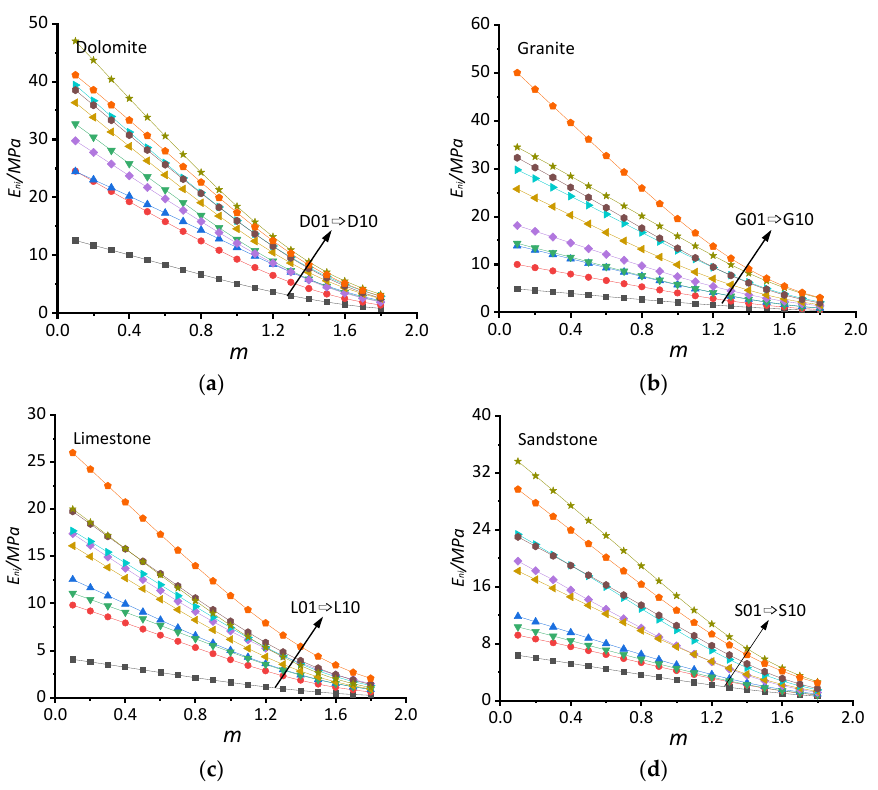
Figure 12. The E ni values with different m values for different rock types. ( a —Dolomite; b —Granite; c —Limestone; d —Sandstone)